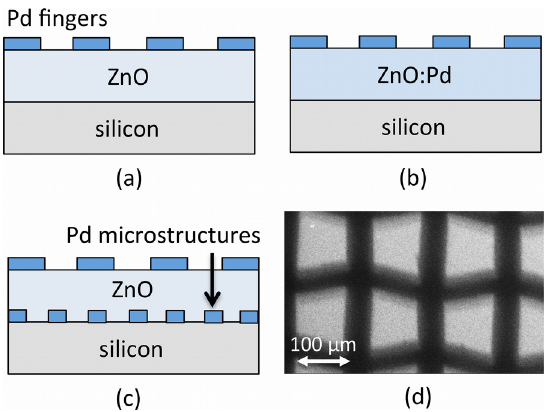
Figure 1. Schematic diagram of the metal-semiconductor-metal (MSM) gas sensor geometries for devices based on ( a) un-doped zinc oxide (ZnO) films; ( b ) Pd-doped ZnO films; and ( c ) ZnO films deposited on Pd microstructures; ( d ) SEM image of a metal microstructure array thermally evaporated through a 100 µm aperture sieve (scale bar = 100